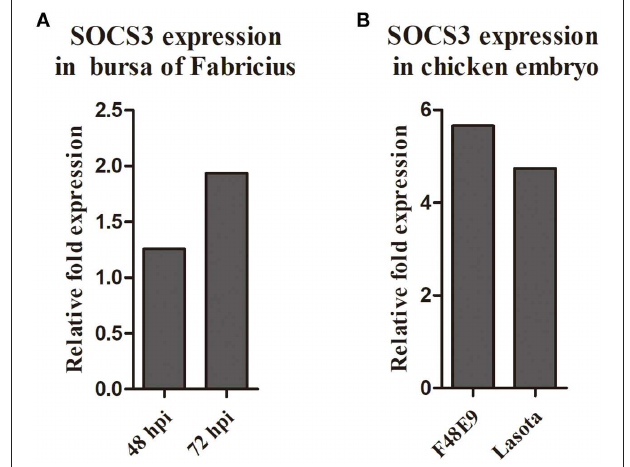
FIGURE 1 | The expression of SOCS3 in the transcriptome sequencing of the chick embryo (A) and bursa of Fabricius (B) .